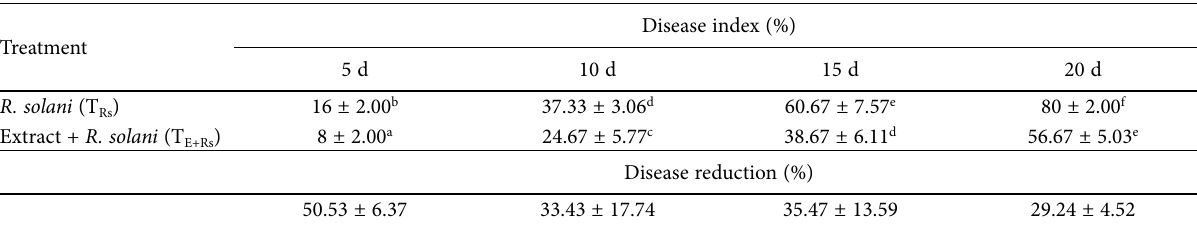
Table 1. Influence of Euphorbia hirta ethanol extract on fungal disease caused by Rhizoctonia solani on tomato plants.